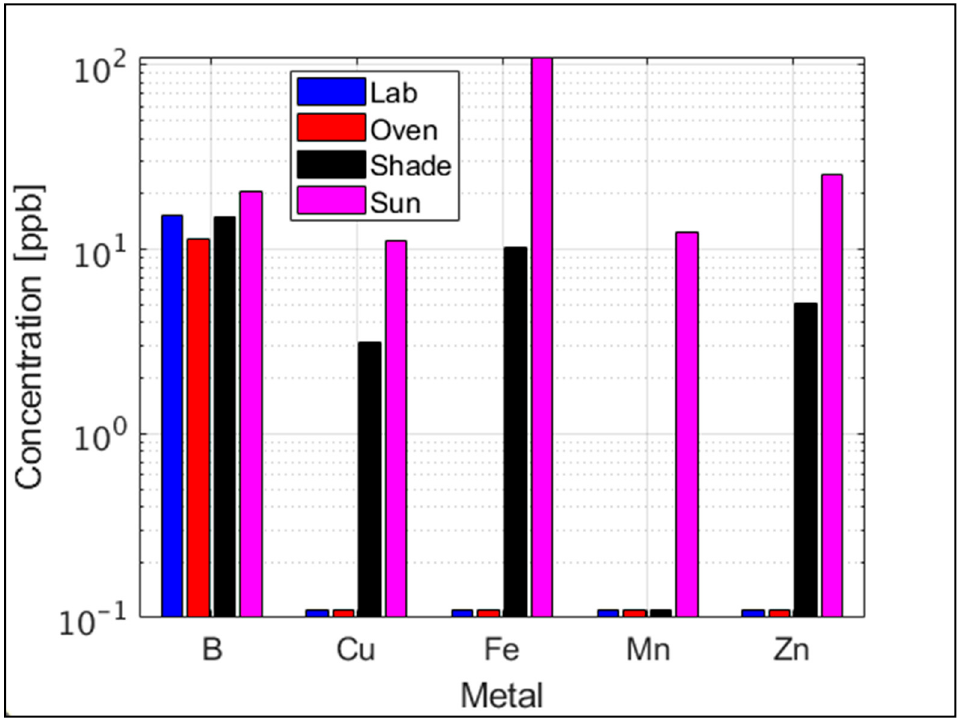
Figure 9. Metals concentrations at leachate water from all examined setups in the fourth week of the experiment. Values of 10 − 1 ppb means readings were below the detection limit.